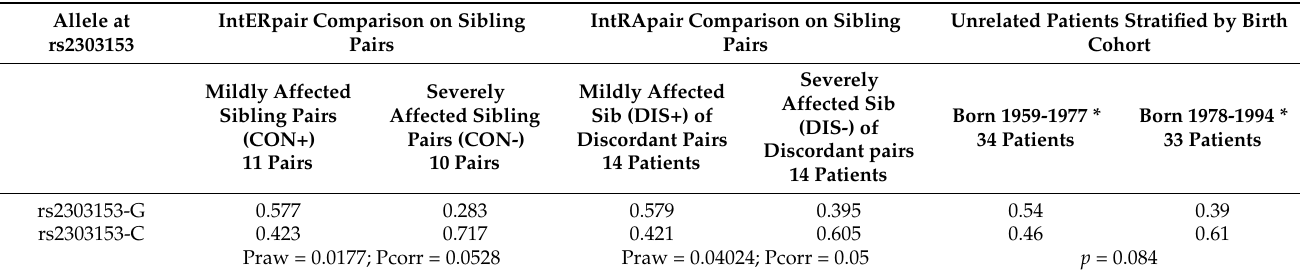
Table 2. Allele frequencies for rs2303153 in mildly and severely affected cystic fibrosis F508del- CFTR homozygous patients. Allele at